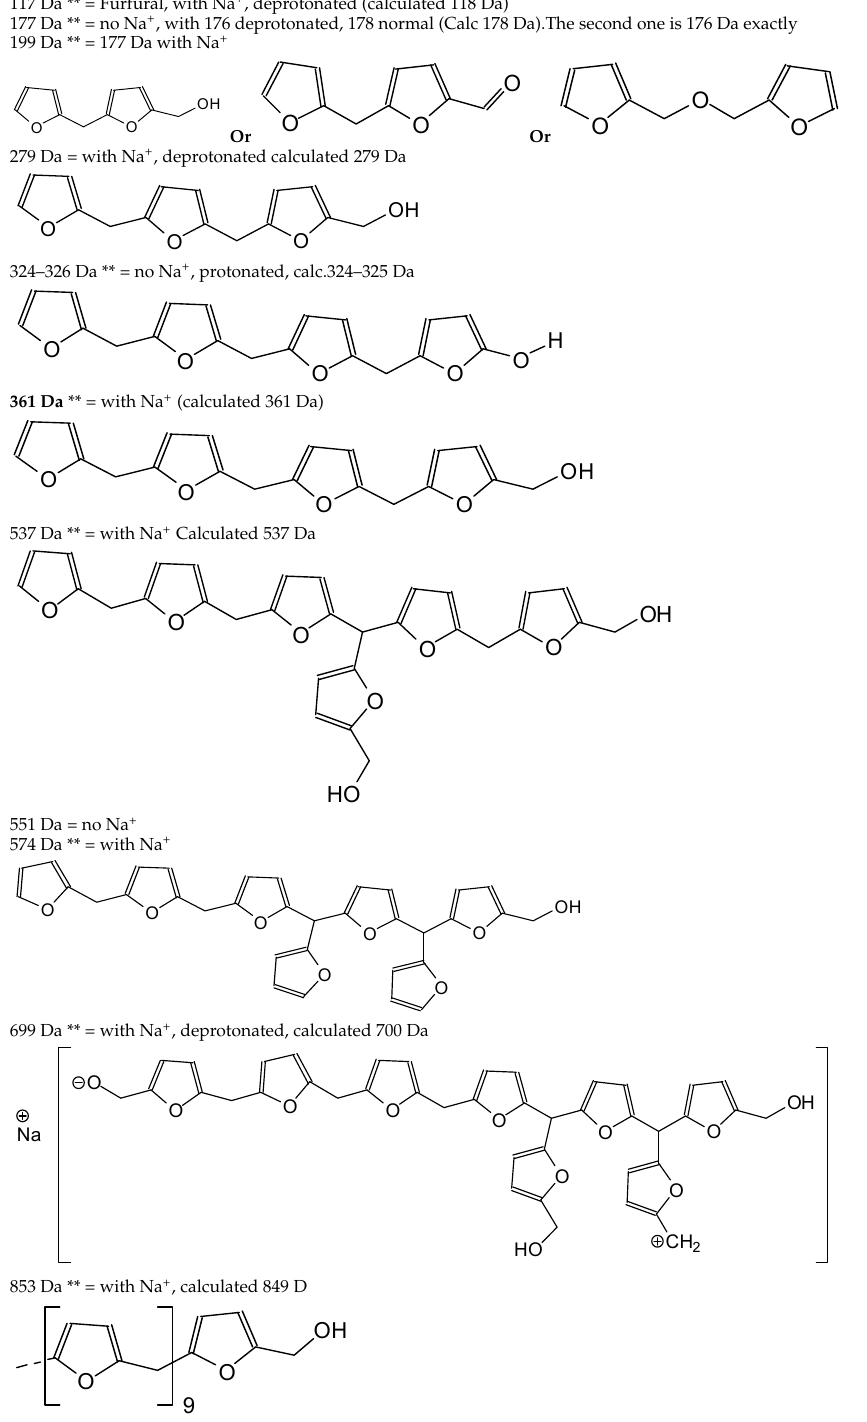
Table 1. Assignment of species to the MALDI ToF peaks for beech wood heat-treated at 300 ◦ C after Polymers 2023 , 15 , 221 heat treatment and underlined in green after a high moisture treatment at 95% relative humidity for one week. Peaks with Asterisks (**) Are also Present after the One Week Wet Treatment 117 Da ** = Furfural, with Na + , deprotonated (calculated 118 Da) 177 Da ** = no Na + , with 176 deprotonated, 178 normal (Calc 178 Da).The second one is 176 Da exactly 199 Da ** = 177 Da with Na + O